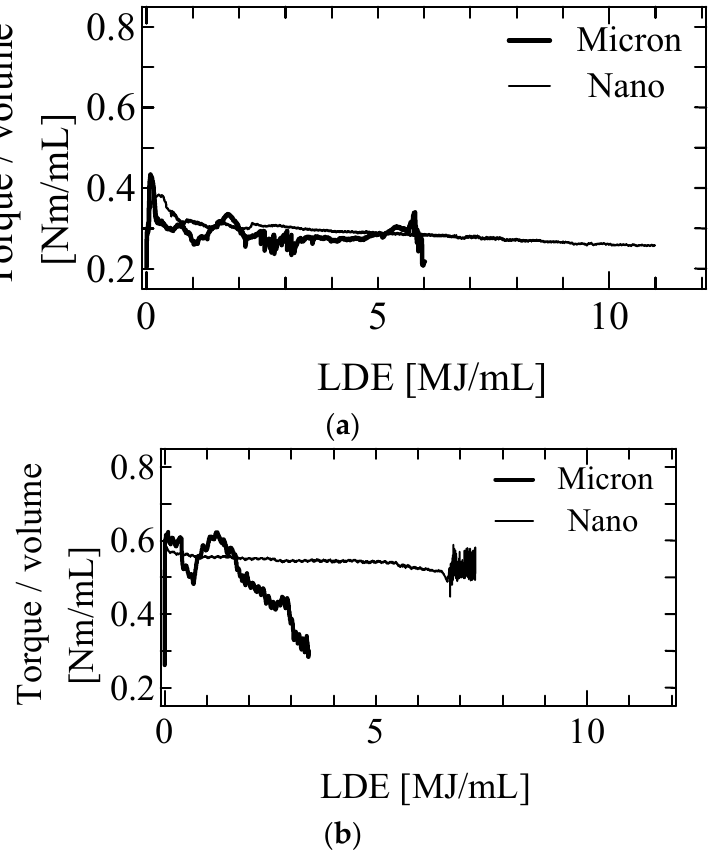
Figure 15. Torque profile in the long-term measurement. ( a ) Parallel plate , ( b ) V-shaped plate.